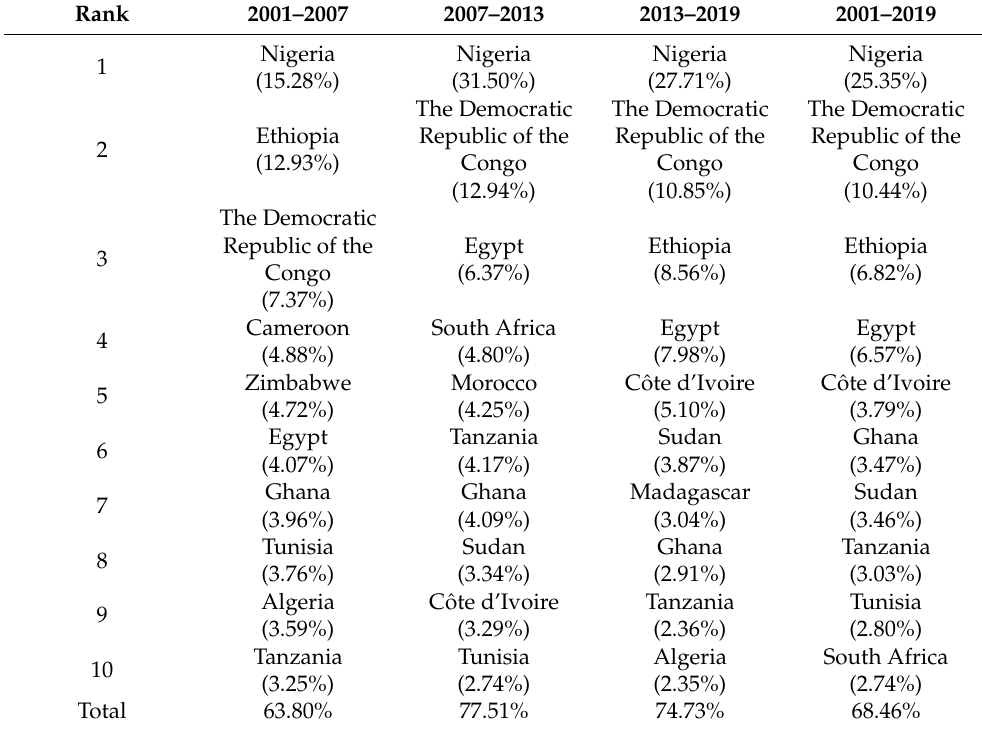
Table 4. Ten major African countries and their share of urban population growth in different